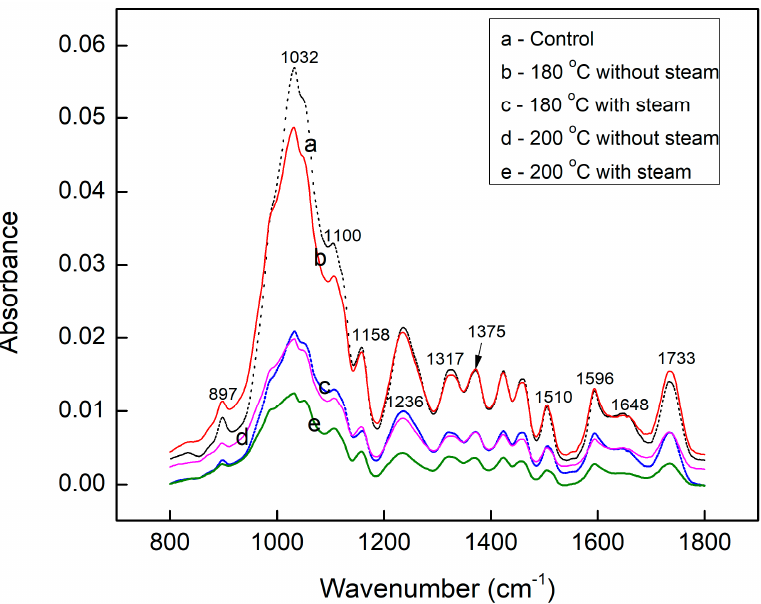
Figure 4. ATR-FTIR fingerprint region spectra of the control and densified sugar maple wood samples.